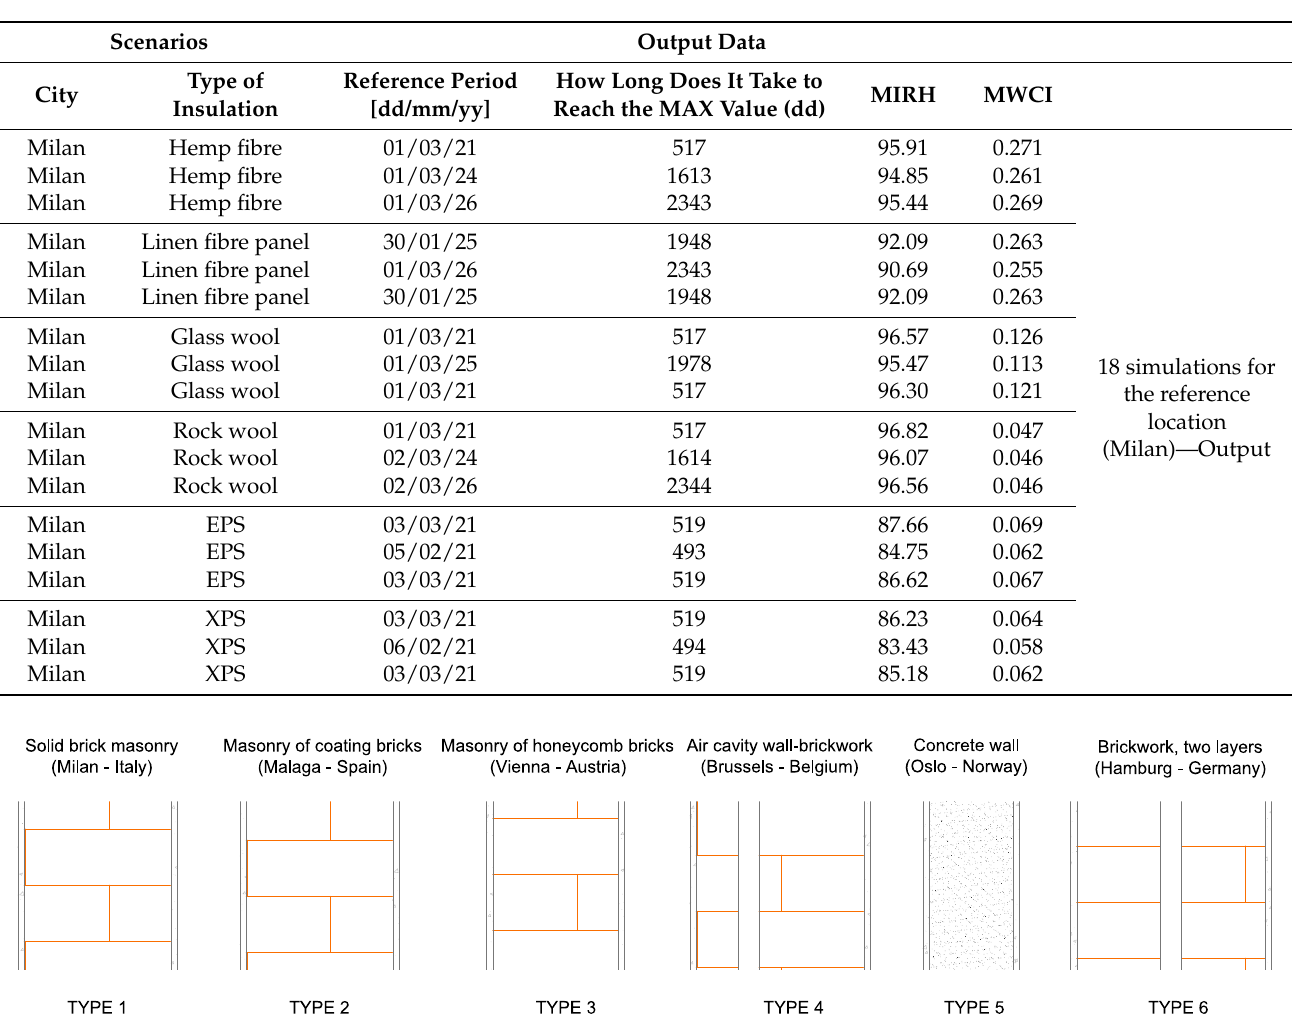
Table 2. Output data related to the city of Milan associated with the value in percentage of maximum interstitial condensation and water content in the maximum insulation, in the 10 years of simulations.